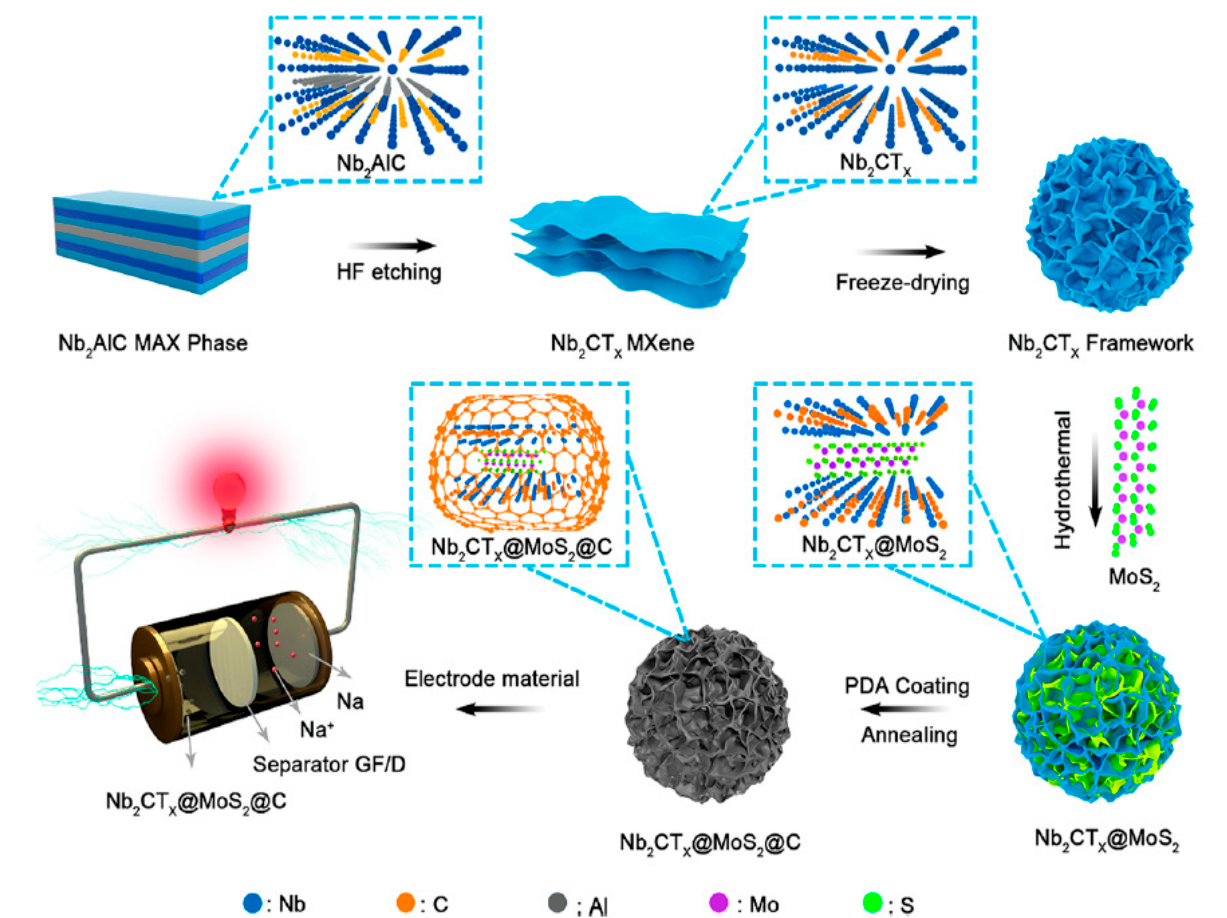
Figure 8. An overview of the manufacturing of the 3D Nb 2 CT x @MoS 2 @C hybrid for usage as the anode in sodium-ion batteries. Reprinted with permission from Ref. [81].